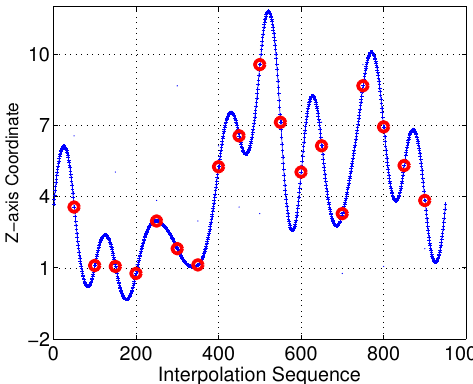
Figure 23. Z -axis of Bezier interpolation three-dimensional (3D) Dubins curves (case 1).